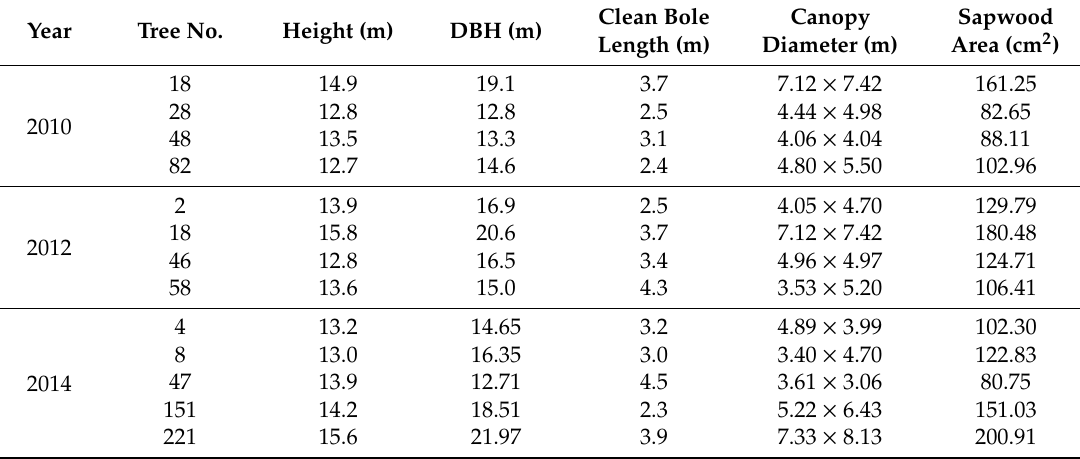
Table 2. Features of sample trees for sap flow